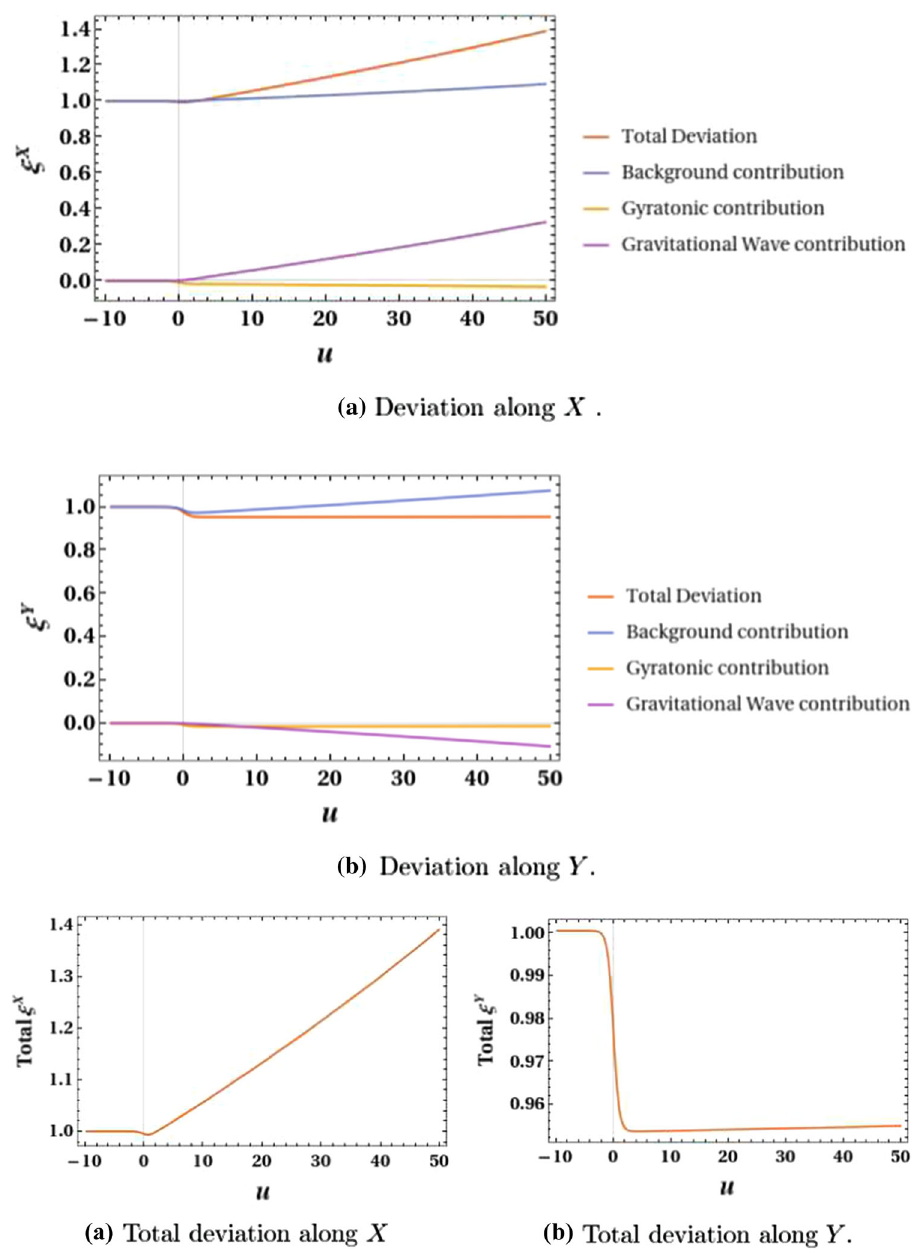
Fig. 10 Total deviation plots for ω =